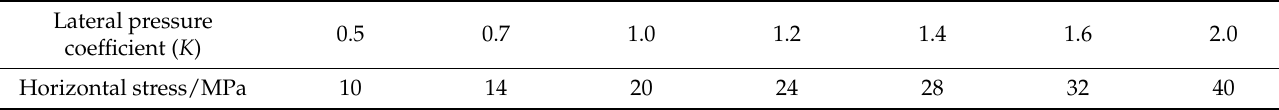
Table 3. Horizontal Stress Parameter Setting.